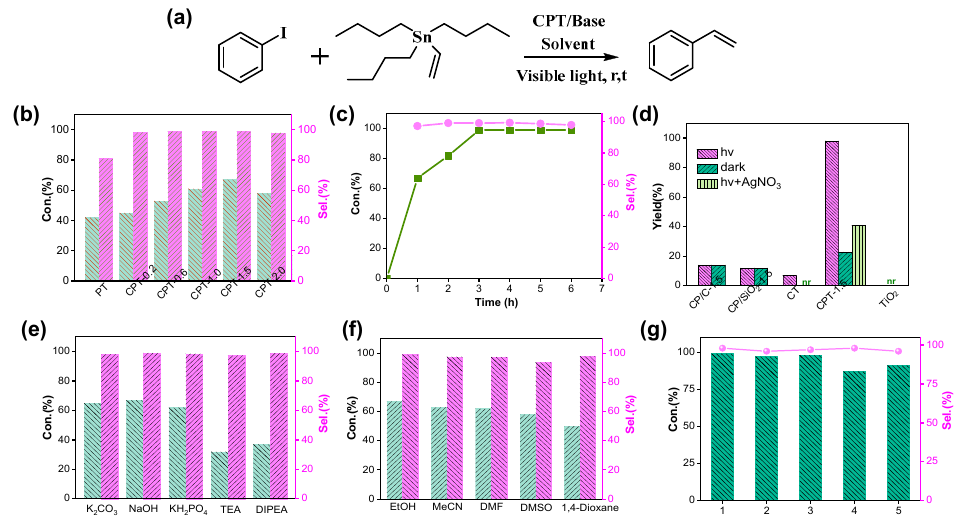
Figure 4. Photocatalytic activity of CPT under various conditions. ( a ) Reaction scheme for the photocatalyzed Stille coupling reaction. ( b ) Effect of the CuPd ratio on the photocatalytic activity of CPT. Effects of ( c ) time, ( d ) different catalysts, ( e ) bases, and ( f ) solvents on the photocatalytic activity. ( g ) Reusability of CPT-1.5 for the photocatalytic Stille coupling reaction.